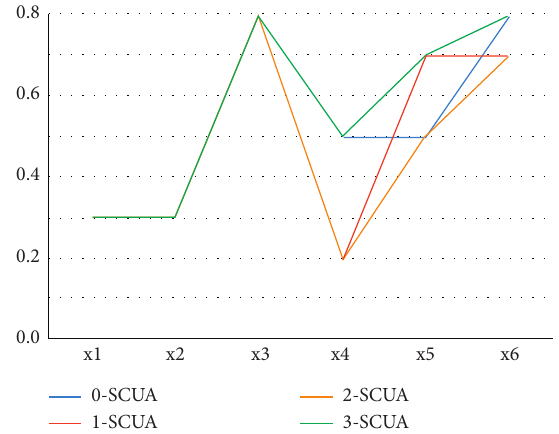
Figure 2: The representations of the four types of SCUA